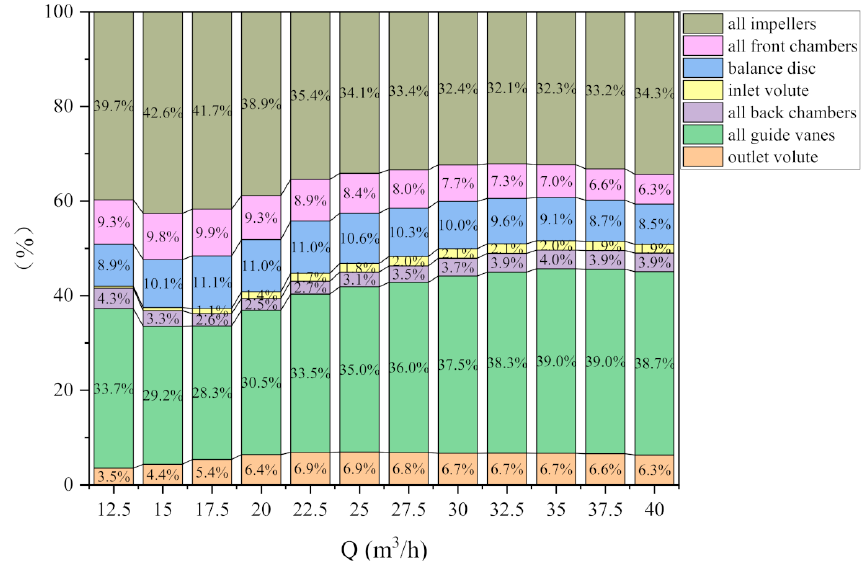
Figure 11. Proportion of each component energy loss in the overall energy loss of the multi‑ stage PAT.